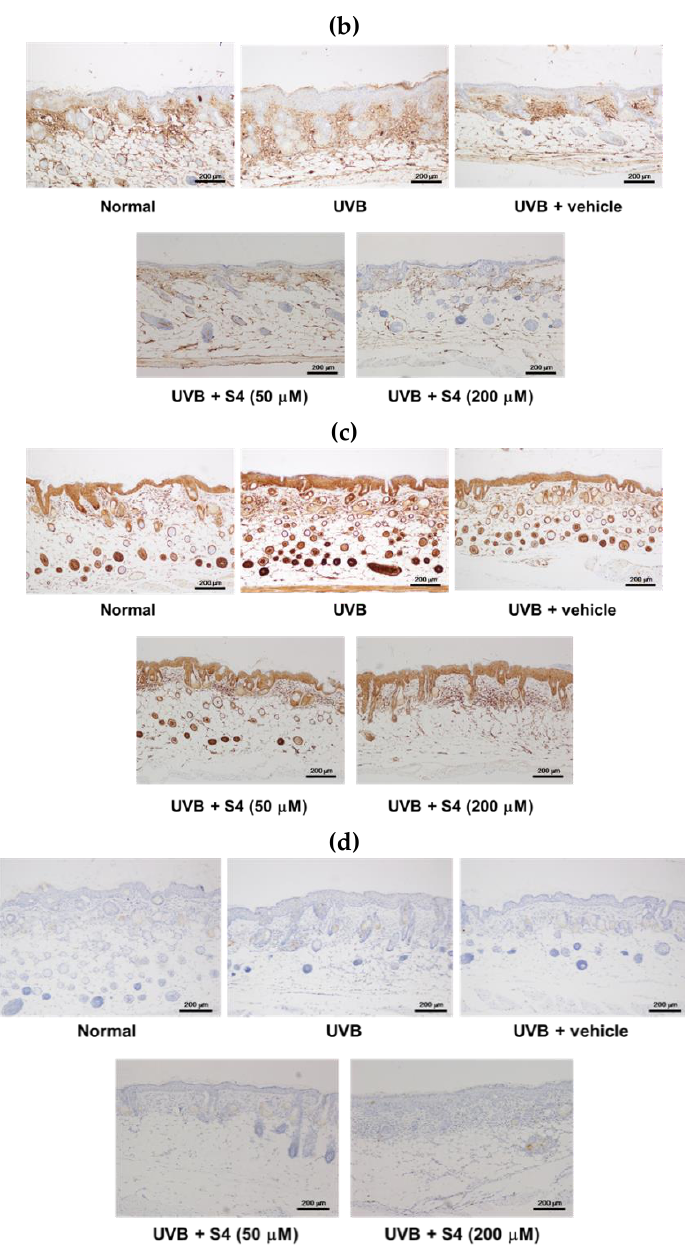
Figure 15. Immunohistological staining of skin slices for ( a ) MMP-1, ( b ) IL-6, ( c ) NF- κ B and ( d ) i-NOS in the hairless mouse skin after chronic UVB exposure and S4 treatment.